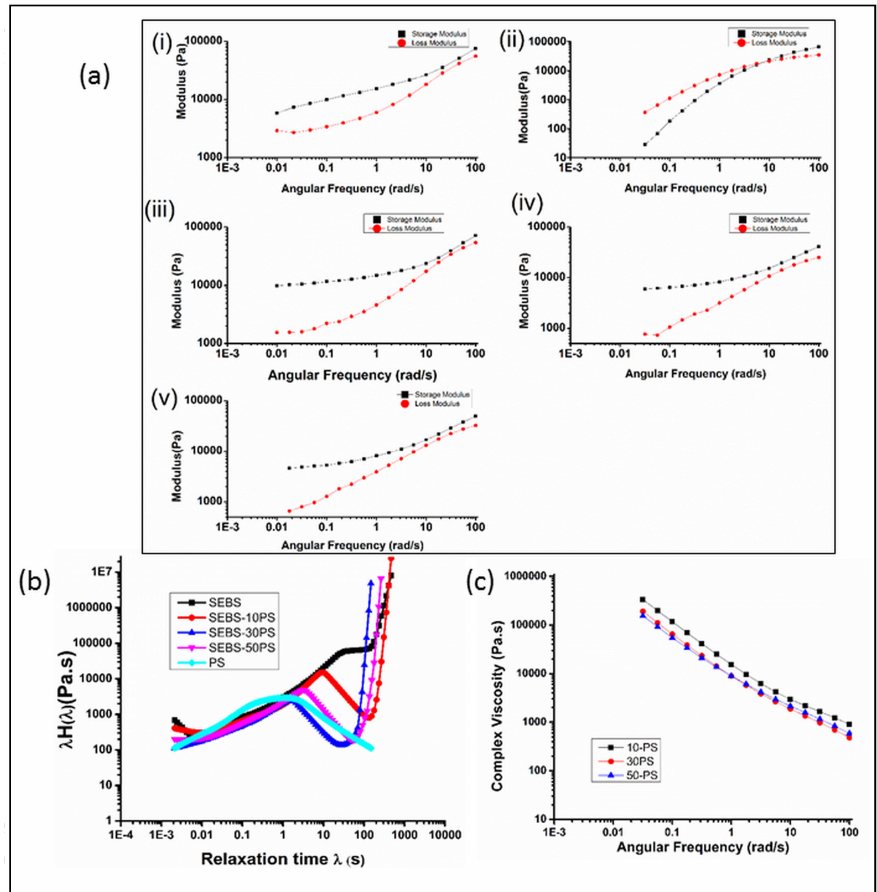
Figure 8. ( a ) Storage modulus and loss modulus plots of (i) SEBS, (ii) PS, (iii) SEBS-10PS, (iv) SEBS-30PS and (v) SEBS-50PS; ( b ) weighted relaxation spectrum; ( c ) complex viscosity